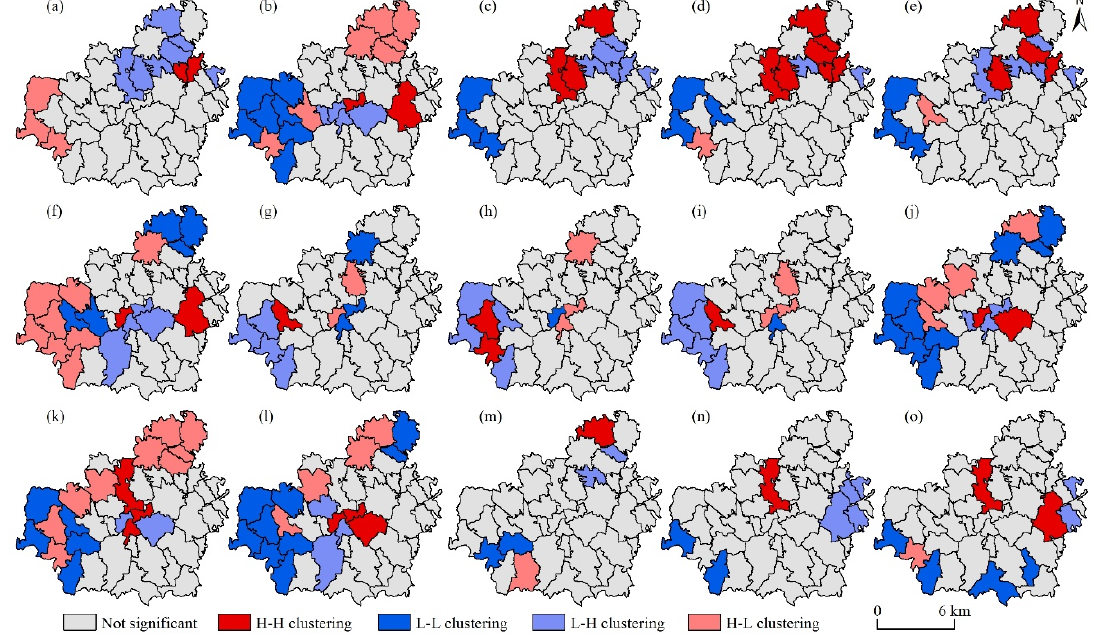
Figure 3. Spatial agglomeration of tradeoffs/synergies between six types of cultural ecosystem services on the supply side. ( a ): Aest-SP; ( b ): Aest-SR; ( c ): Aest-Cult; ( d ): Aest-Edu; ( e ): Aest-Recr; ( f ):